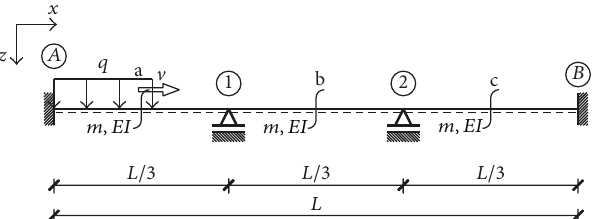
Figure 16: Three-span continuous uniform beam loaded with mov- ing distributed load.